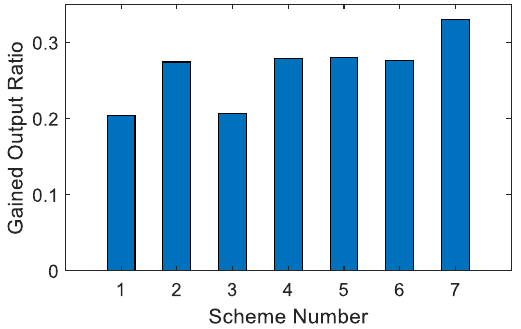
Figure 13. Comparison of water production ratio.